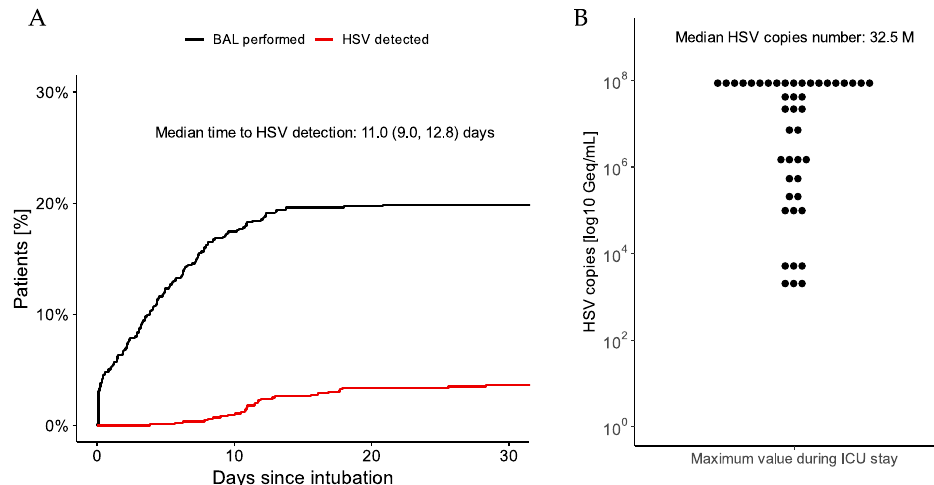
Figure 1. ( A ) Rates of BAL examinations (black line) and HSV occurrence (red line) since intubation for patients with cardiogenic shock. ( B ) Distribution of highest HSV copy number measured per patient during ICU stay.